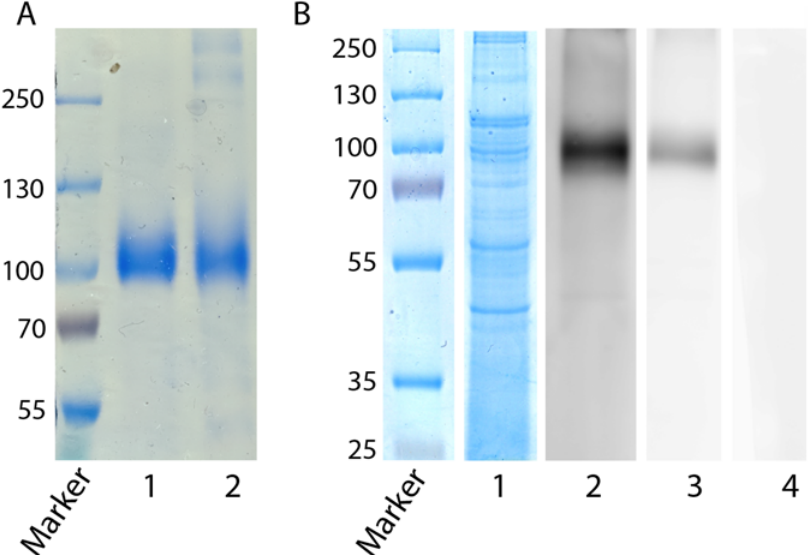
Fig 1. Expression of recombinant Ir86-1 and Ir86-2 and detection of Ir86-1 and Ir86-2 in I . ricinus gut lysate. A. Purified Drosophila -expressed recombinant Ir86-1 (Lane 1) and Ir86-2 (Lane 2) electrophoresed on SDS 7.5% polyacrylamide gel and stained with Coomassie blue. B. Gut lysate from 20 adult female I . ricinus tick guts electrophoresed on SDS 10% polyacrylamide gel stained with Coomassie blue (Lane 1) or transferred to a PVDF membrane which was probed with antiserum (1:200) from rabbits vaccinated against rIr86-1 (Lane 2), rIr86-2 (Lane 3) or with antiserum from the control rabbit vaccinated against ovalbumin (Lane